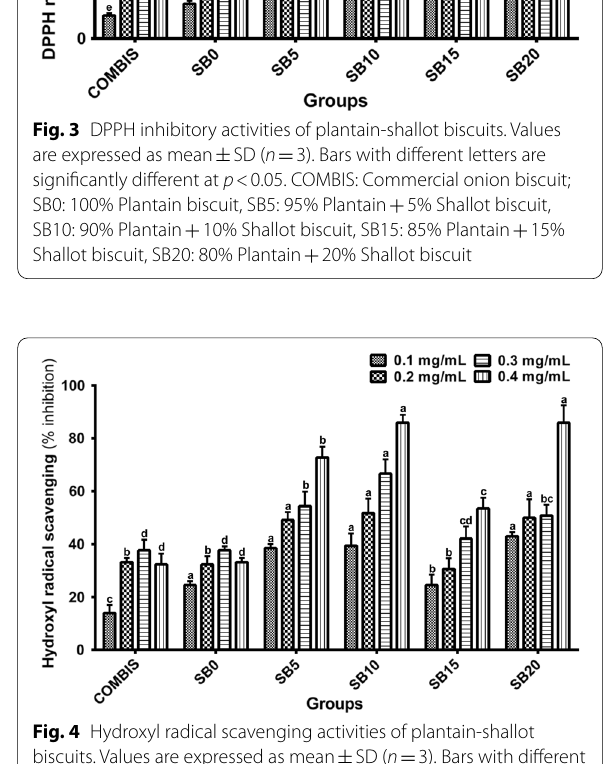
SD ( n 3). Bars with different ± = 5% + 10% Shallot biscuit, SB15: 85% + 20% Shallot +